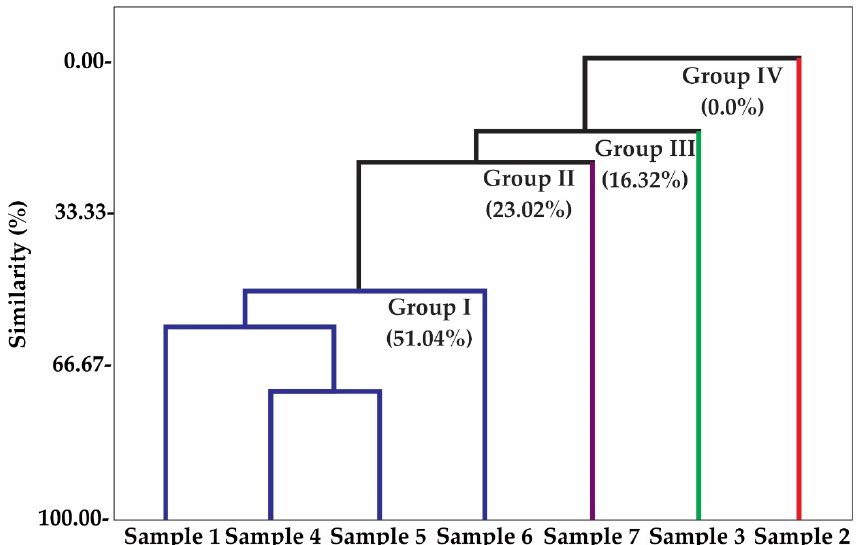
Figure 2. Dendrogram presenting the relational similarity of the volatile compound classes identified in the aromas of seven bee propolis samples from Apis mellifera .